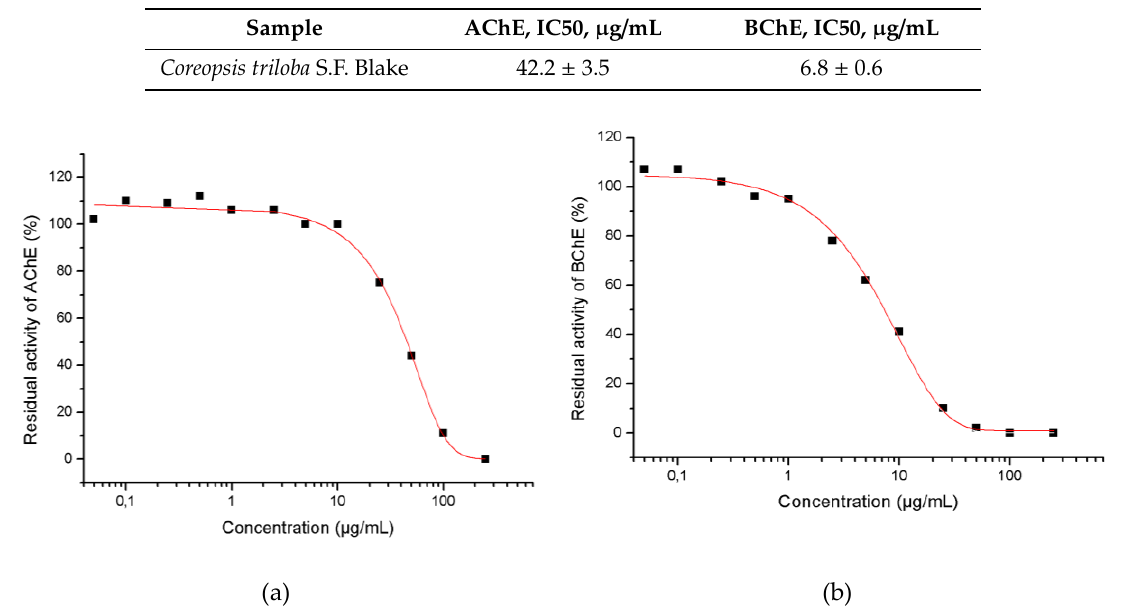
Table 4. Cholinesterase inhibitory activity.